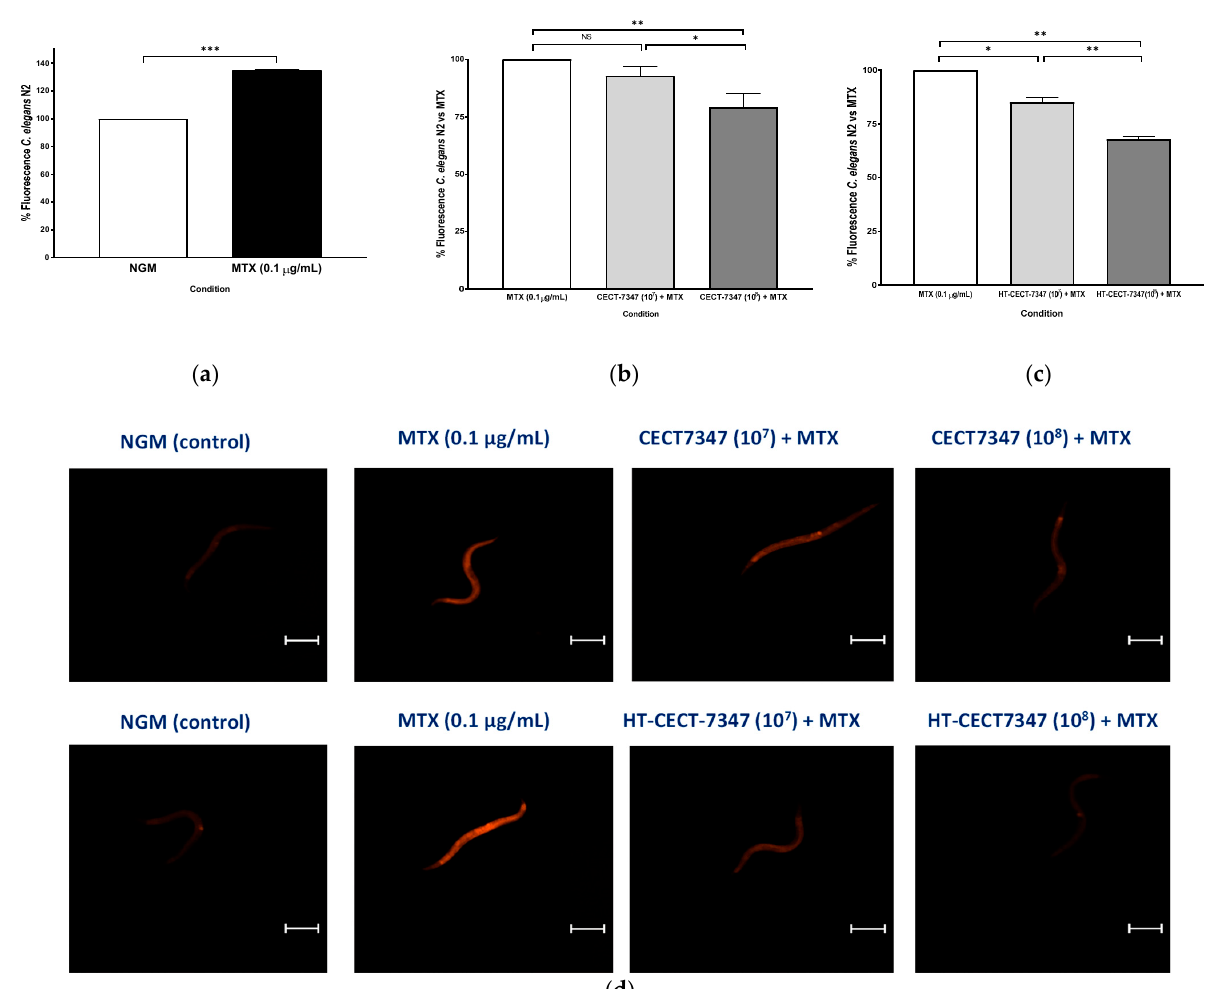
Figure 6. ( a ) Percentage of fluorescence intensity of Nile Red in worms without gut damage (NGM condition) or in worms with MTX-induced intestinal damage at dose of 0.1 μ g/mL. Data are the average of two independent experiments ( n = 60/condition); ( b ) Percentage of fluorescence of worms treated with MTX at 0.1 μ g/mL (gut damage condition) with CECT- 7347 or ( c ) with HT-CECT-7347 at two different doses (10 7 and 10 8 cells) + MTX (0.1 μ g/mL). Values are the average of two independent assays. ( n = 60/condition). *** Significant at p -value ≤ 0.001. ** Significant at p -value ≤ 0.01; * Significant at p - value ≤ 0.05. NS: No significant differences. One-way ANOVA was applied. ( d ) Representative images of Nile Red staining in live young adult C. elegans in a wild-type N2 animal under fluorescence microscopy. Worms treated with MTX to induce intestinal damage were fed with CECT-7347 or HT- CECT-7347 strain at two doses (10 7 and 10 8 cells). Scale bar 250 μ m. Original image taken by the authors for this paper with a Nikon-SMZ18 fluorescence stereomicroscope.